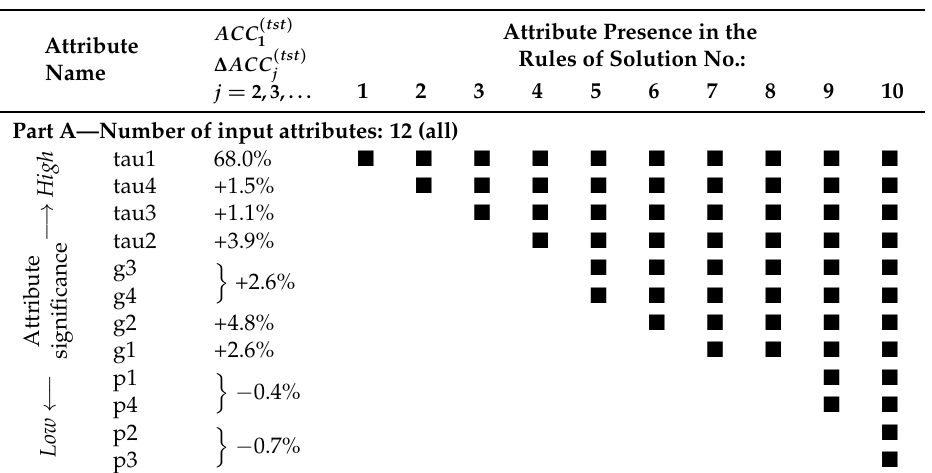
Table 5. Illustration of attribute presence and significance in the Electrical Grid Stability Simulated Data Set